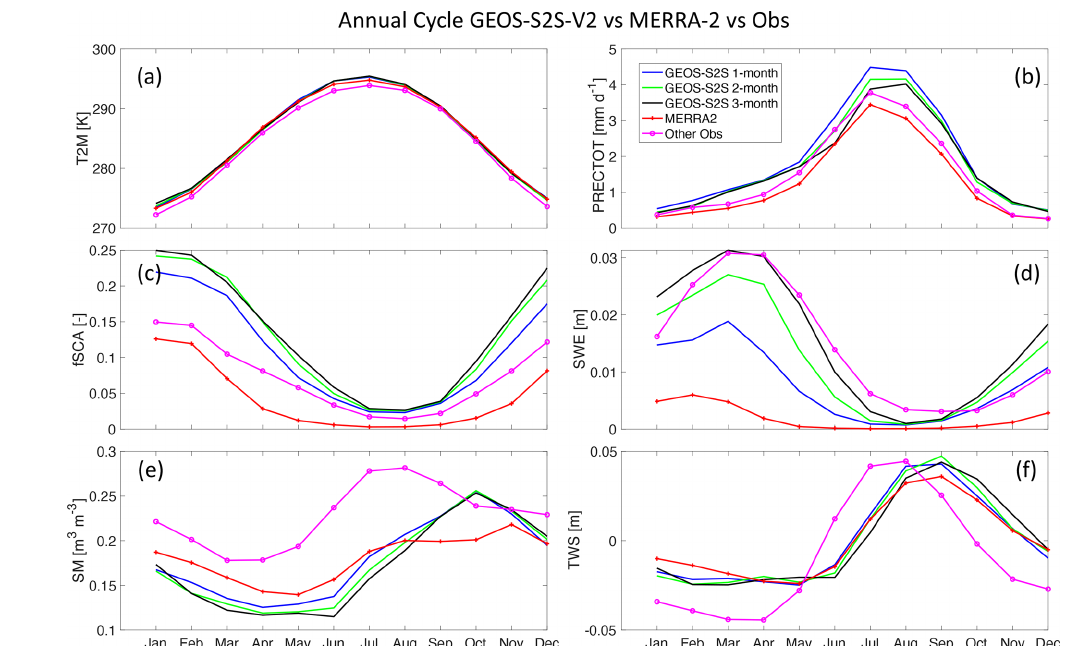
Figure 4. Annual cycle for each variable, averaged over the HMA domain. The annual cycles from the GEOS-S2S forecasts are shown for all lead times (blue, green, and black curves), and those estimated from the MERRA-2 reanalysis (red) and the reference data products (pink) are shown for